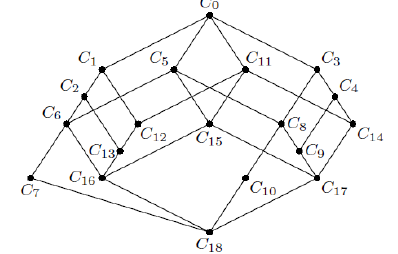
Figure 2. Concept Lattice of Formal Context F given in Figure